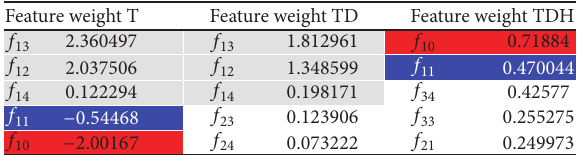
Figure10:FeaturerankingoftheaccumulatedT,TD,andTDHstate vectorssortedaccordingtoranking.Thefeatureshighlightedbyblue and red show interesting shifts in importance from state to